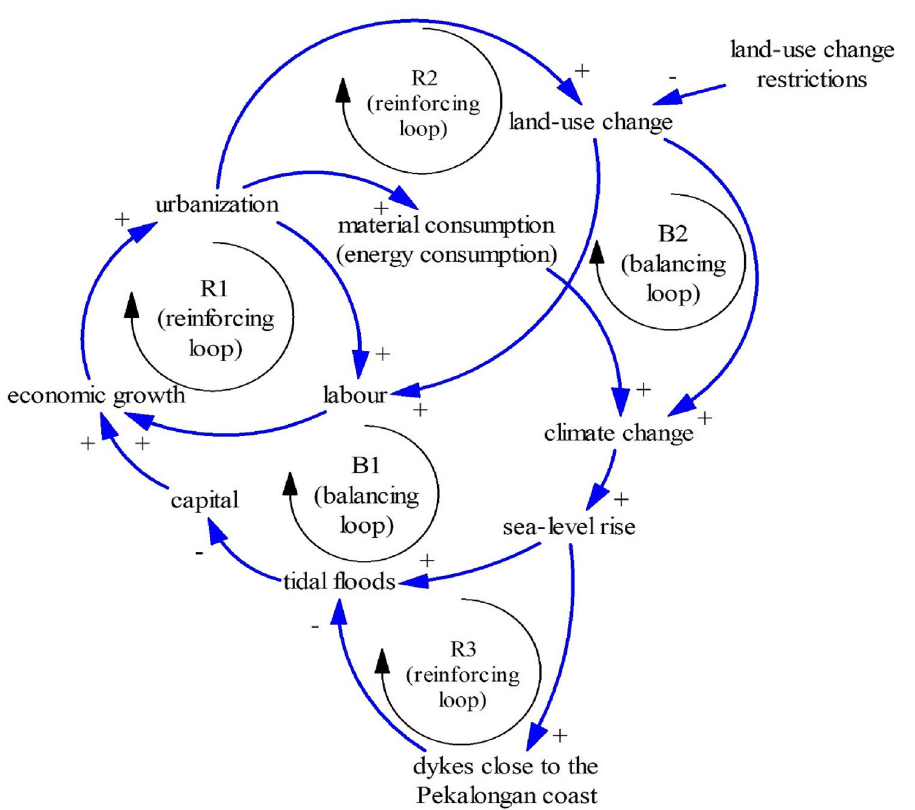
Figure 9. The Limits to Growth